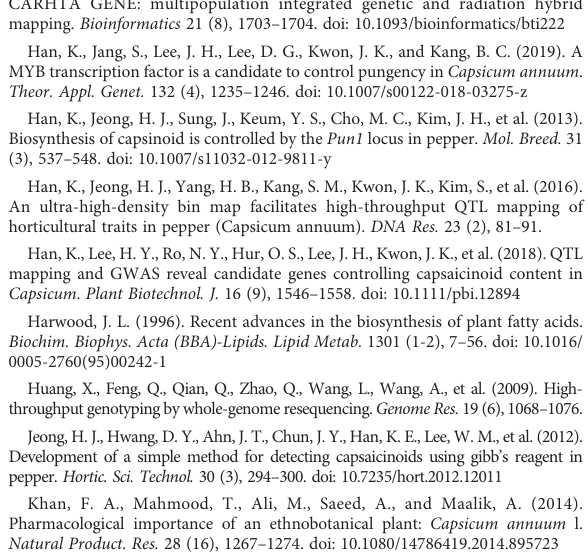
SUPPLEMENTARY FIGURE 1 SNP densitiesofthe ‘ PJ ’ F2population.Thescale barontherightindicates the number of SNPs within a 1 Mb window size. SUPPLEMENTARY FIGURE 2 Comparison of the genetic map of the ‘ PJ ’ F 2 population with the physical map. The scale bar on the left shows the genetic map position (cM). SUPPLEMENTARY FIGURE 3 The comparison between the detected QTLs and the pAMT genes on chromosomes 3 and 9. The yellow box and the red arrow indicate the location of the QTL and the pAMT gene, respectively. SUPPLEMENTARY FIGURE 4 Amino acid sequence of the translated protein of Pun1 . Amino acid sequences were obtained from the reference genome of C. annuum ‘ Takanotsume, ’ C. baccatum ‘ PBC81, ’ and C. chinense ‘ Habanero. ’ The different residues are marked in white text in black boxes. SUPPLEMENTARY FIGURE 5 Amino acid sequence of the translated protein of Pun3 . Amino acid sequences were obtained from the reference genomes of C. annuum ‘ Takanotsume ’ and C. baccatum ‘ PBC81. ’ The different residues are marked in white text in black boxes. SUPPLEMENTARY FIGURE 6 Amino acid sequences of the translated protein of CaKR1 . Amino acid sequences were obtained from the reference genomes of C. annuum ‘ Takanotsume, ’ C. baccatum ‘ PBC81, ’ and C. chinense ‘ Habanero. ’ The different residues are marked in white text in black